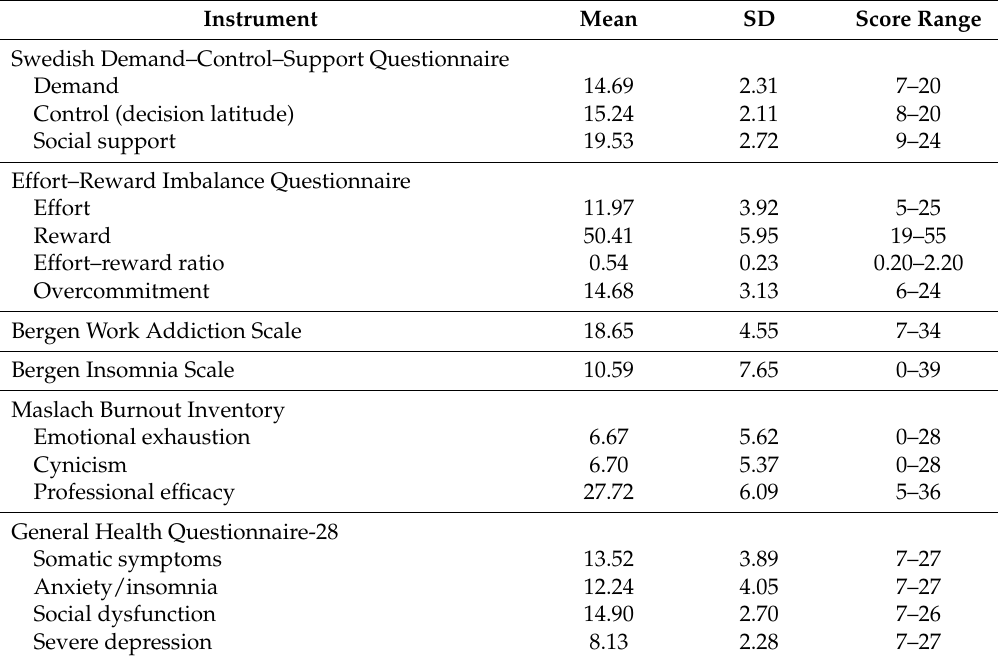
Table 1. Descriptive data of the instruments included in the study